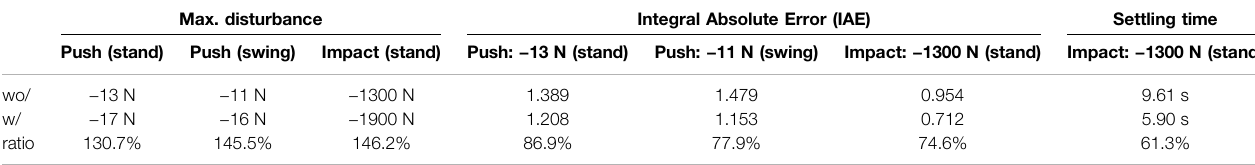
TABLE 1 | Summary of Draco